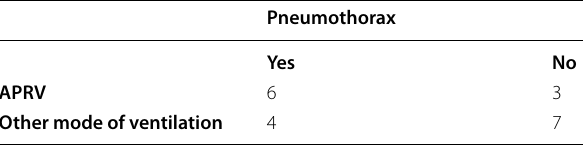
Pneumothorax Yes No APRV 6 3 4